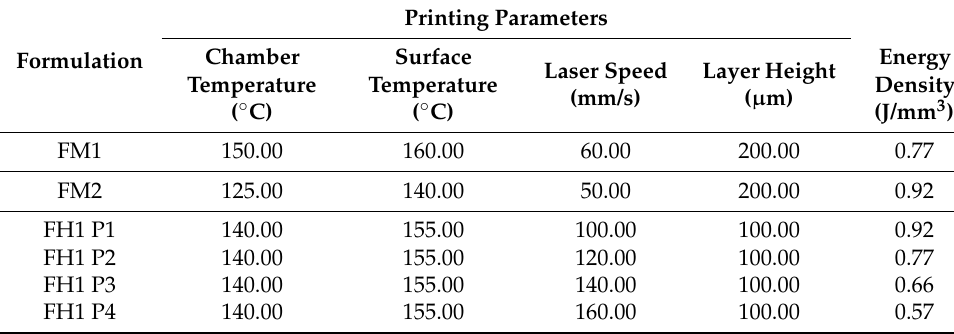
Table 2. SLS printing parameters for printing irbesartan SLS